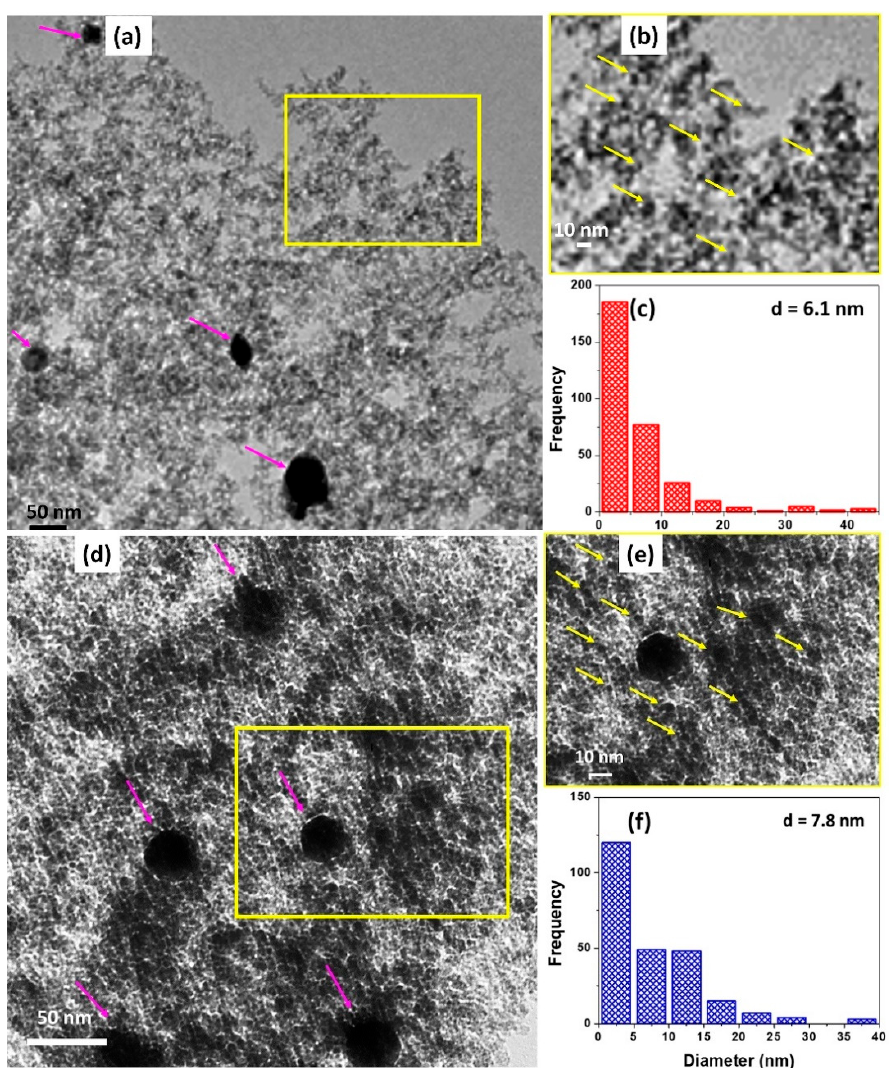
Figure 2. TEM micrographs and the corresponding estimated particle size distribution of Pd/SiO 2 aerogel catalysts ( a – c ) before, and ( d – f ) after the catalytic CO